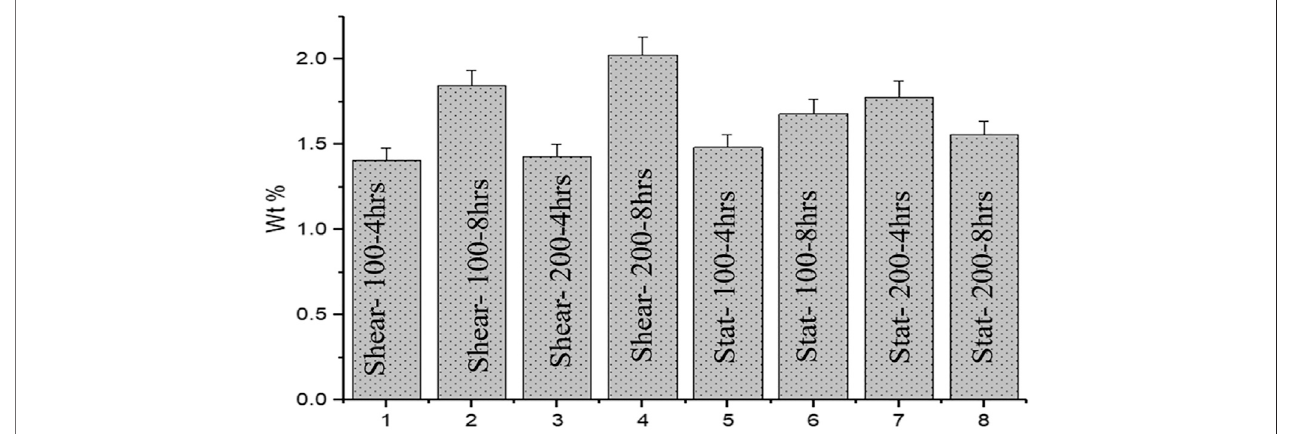
FIGURE 6 | Bar chart represents weight percentage (wt%) for Ti for 8 different cases. Different MXene concentrations and exposure durations did not show any signi fi cant difference in MXene uptake by MDA-231 cells.